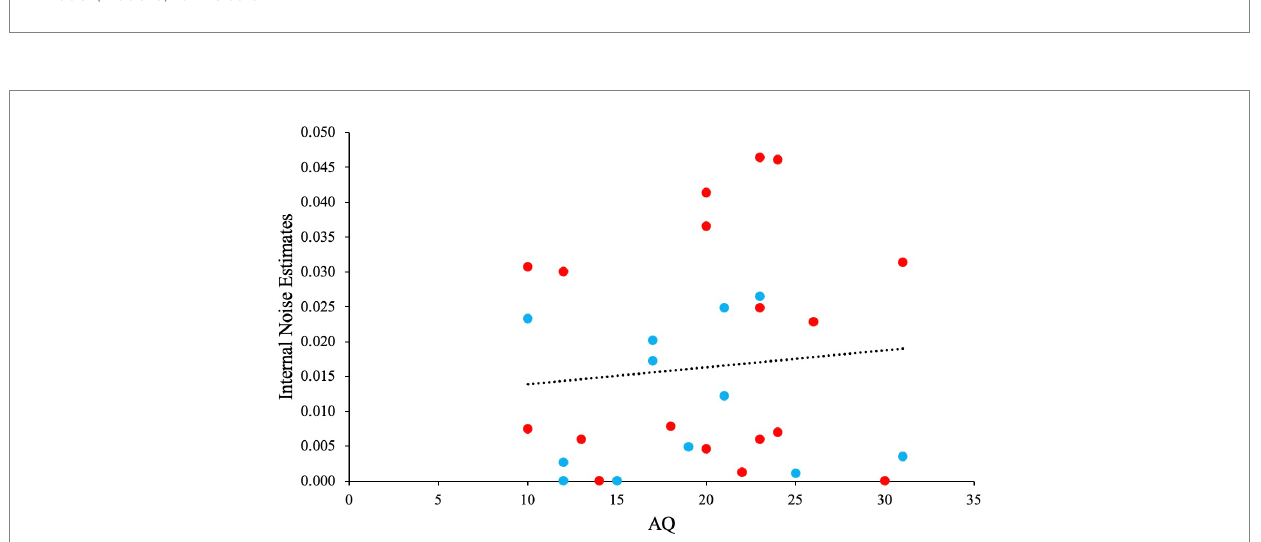
FIGURE 15 The relationship between AQ and Internal Noise. Blue scatter illustrates participants that showed SR, and red scatter illustrates participants that did not show any SR.